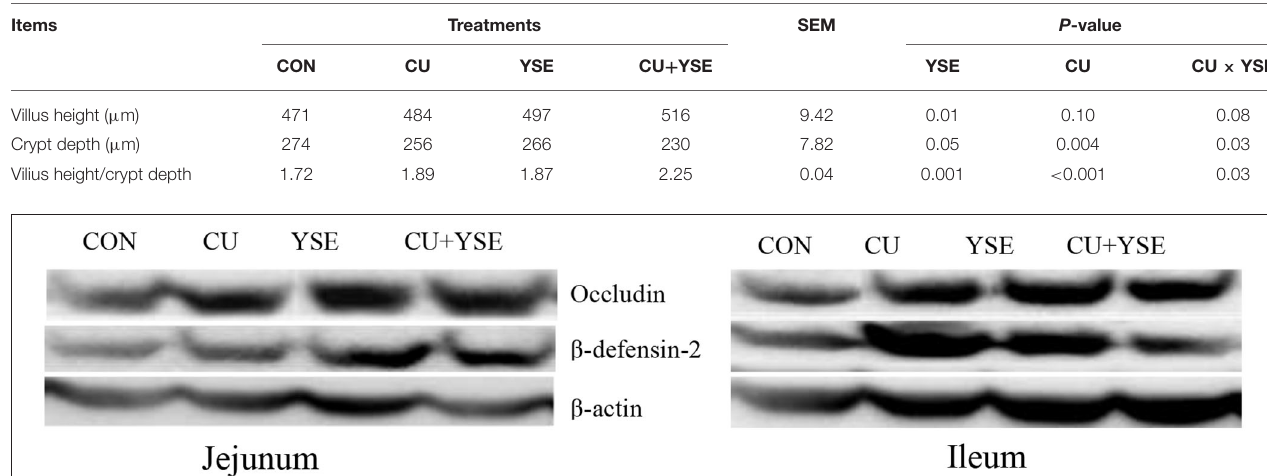
TABLE 6 | Effects of dietary YSE and oral CU on morphology of ileum in weaned piglets. Items Treatments